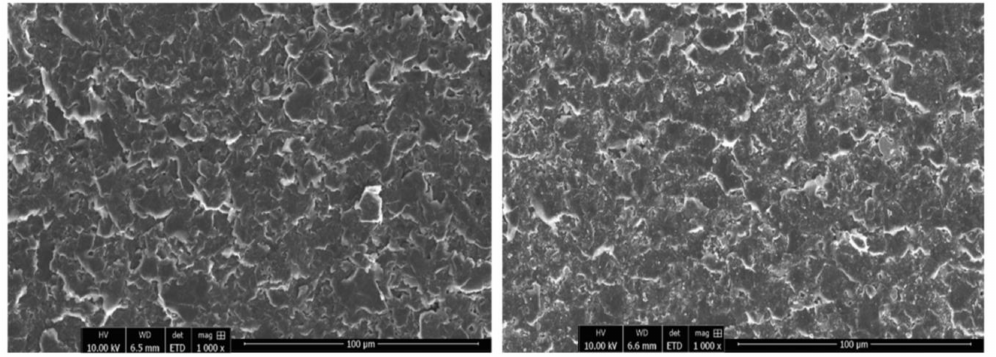
Figure 1. SEM images of graphene paste electrode ( left ) and clay paste electrode ( right ), 1000 ×